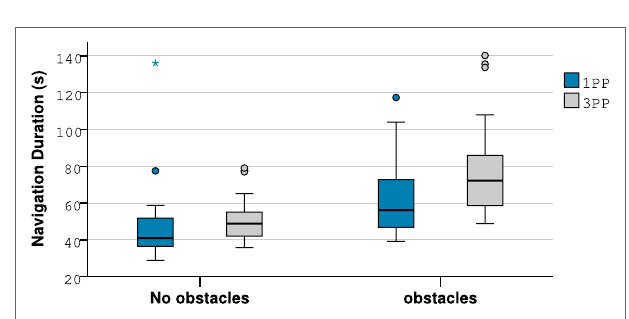
FigUre 9 | Boxplot of the questions of the viewpoint factor: perception (Q1), interactions (Q2), navigation (Q3), accurate interactions (Q4).